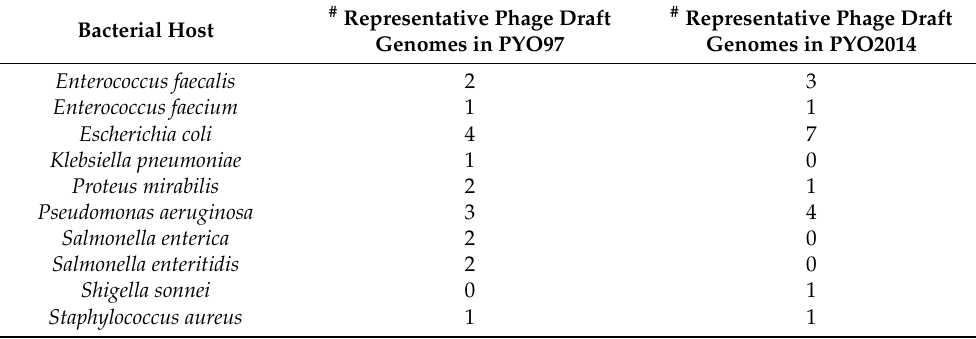
Table 5. Number of phage draft genomes from the two samples which HostPhinder predicted to infect the respective host. Only results having a score higher than the reliability threshold of 0.1 are reported. Bacterial Host